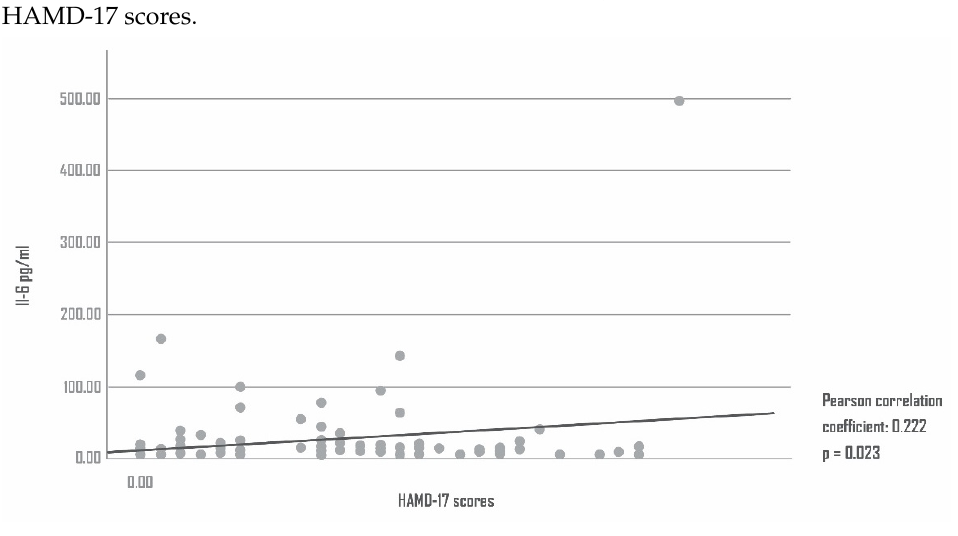
Figure 2. IL-6 levels and HAMD-17 scores.